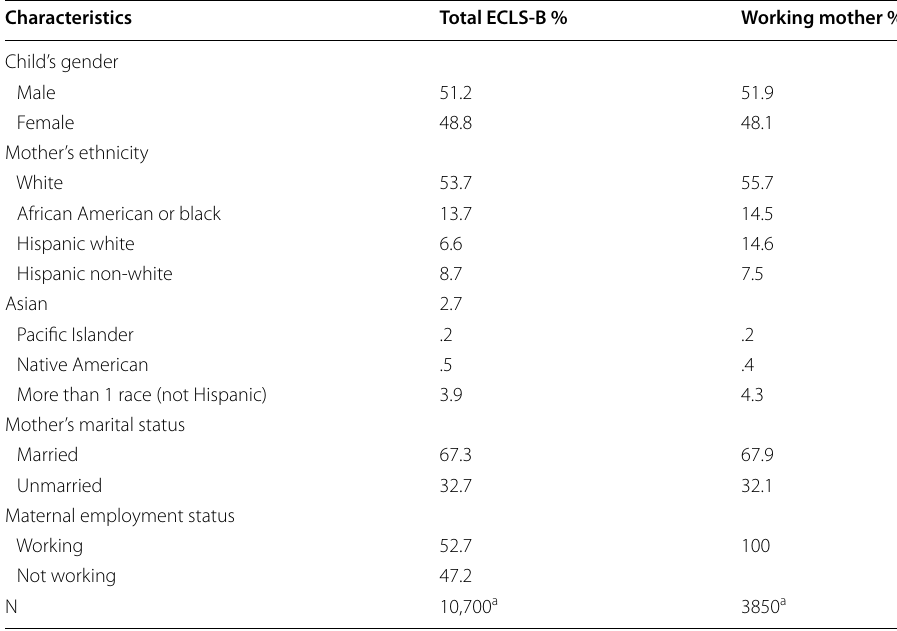
Data from ECLS‑B restricted‑use data file. Weighted frequencies are representative of the children born in the U.S. in the year 2001 a Samples sizes are rounded to the nearest 50, consistent with the requirements of the National Center for Education Statistics